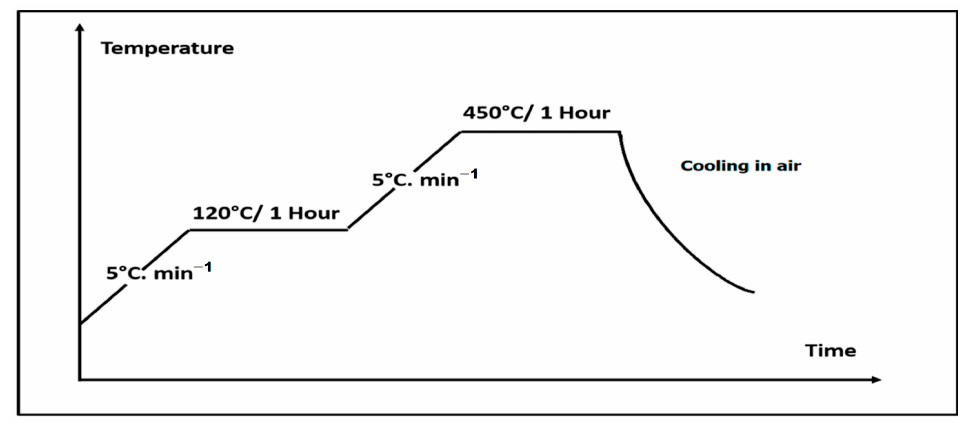
Figure 4. Heat treatment